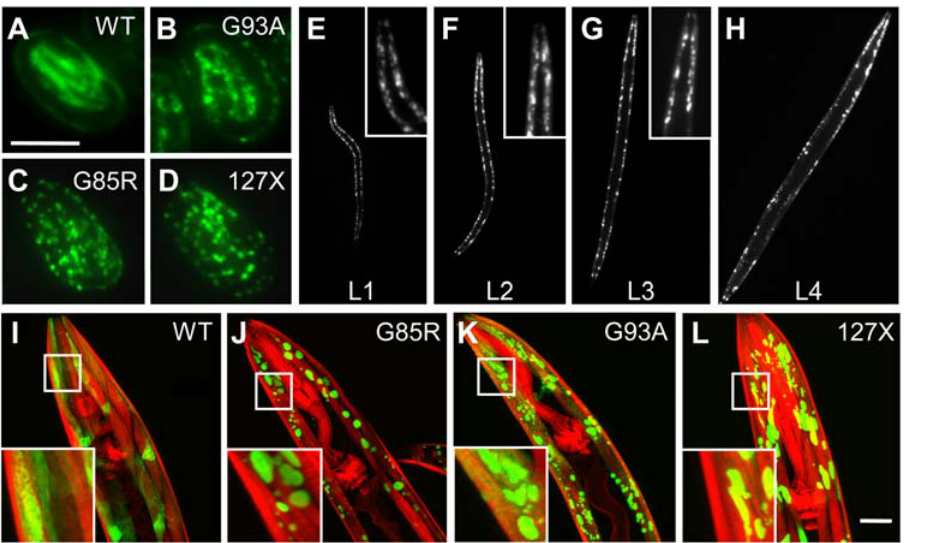
Figure 1. SOD1 mutant proteins aggregate in the body wall muscle cells of C.elegans . ( A–D ) Fluorescent micrographs of three-fold embryos showing the diffuse pattern of WT SOD1-YFP fusion ( A ) and punctate fluorescence of YFP fusions of G93A ( B ), G85R ( C ) and 127X ( D ). ( E–H ) G85R animals in all larval stages – L1 ( E ), L2 ( F ), L3 ( G ), L4 ( H ) – display punctate fluorescent pattern. Inserts are close-ups of the head area. ( I–L ) Confocal projections of transgenic adult animals showing the distribution of the SOD-YFP fluorescence (green) and Rhodamine-phalloidin stained myofilaments (red). WT SOD1 protein exhibits diffuse, if patchy, fluorescence ( I ), while all mutant strains contain discrete fluorescent foci as well as some diffuse fluorescence ( J through L ). Inserts are close-ups of the boxed areas. Scale bars in A and L are 50 and 20 micrometers, respectively. All images are of representative animals with typical fluorescent patterns.